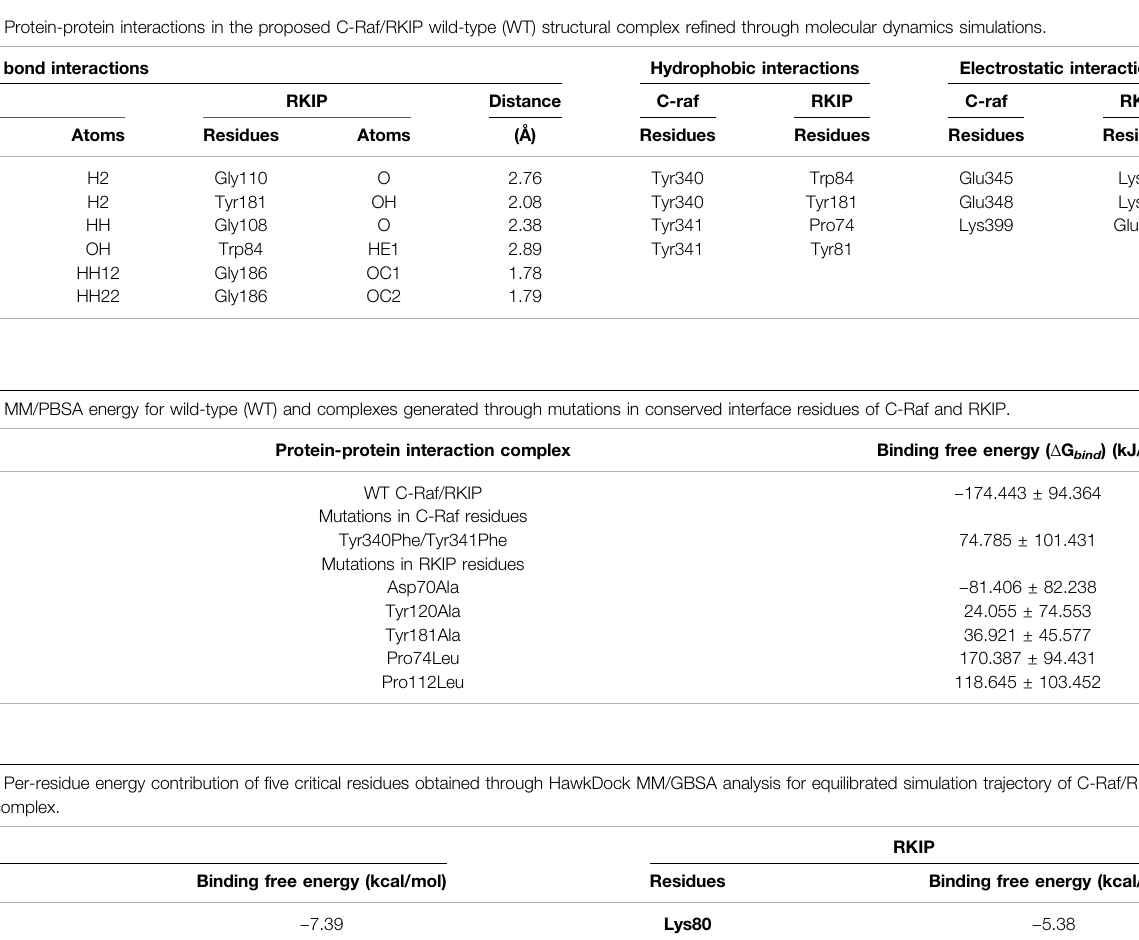
TABLE 3 | Protein-protein interactions in the proposed C-Raf/RKIP wild-type (WT) structural complex re fi ned through molecular dynamics simulations. Hydrogen bond interactions